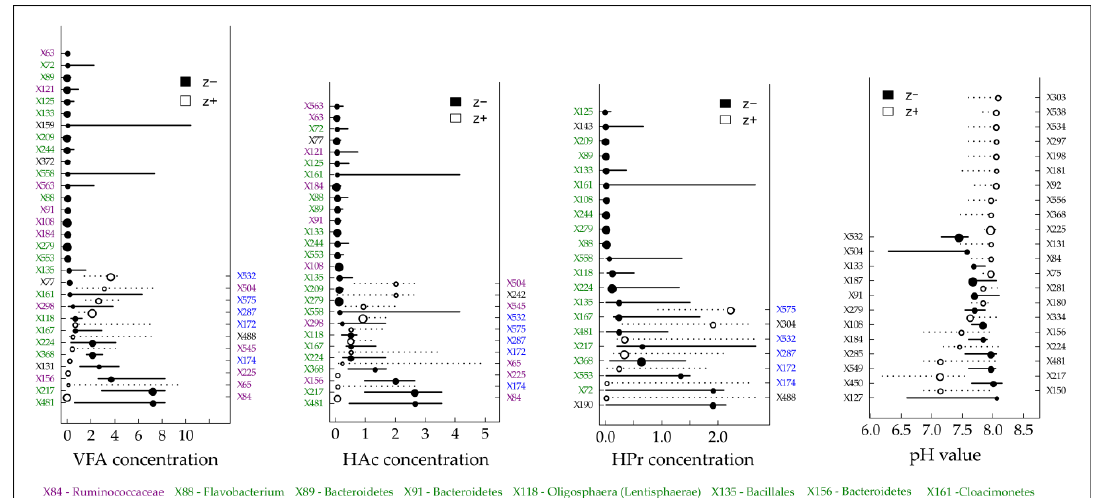
Figure 5. Threshold Indicator Taxa Analysis (TITAN) on the individual density of detected terminal restriction fragments (TRFs) in response to the gradients of the total volatile fatty acids (VFA), acetic acid (HAc), propionic acid (HPr) concentration and the pH value. Circles represent the change points of indicative TRFs that decreased (black, negative response, left y-axis) or increased (white, positive response, right y-axis) with increasing gradients and are sized based on the magnitude of the response (z-score; the larger the circle, the stronger the response). Horizontal lines represent 5th and 95th quantiles of 500 bootstrap replicates. Color code: green = negative responding TRFs in all gradients except pH value, blue = positive responding TRFs in all gradient except pH value, violet = negative/positive responding TRFs for VFA and HAc concentration.